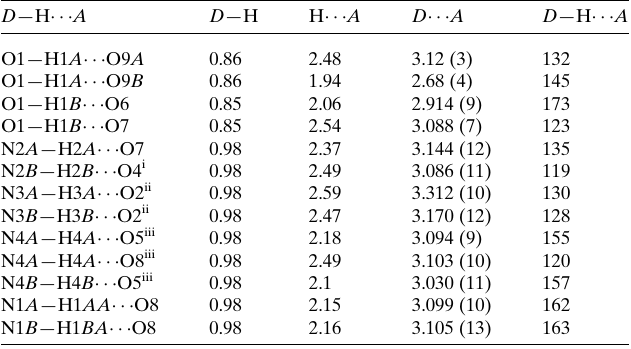
Table 1 Hydrogen-bond geometry (A˚ , (cid:3) ).